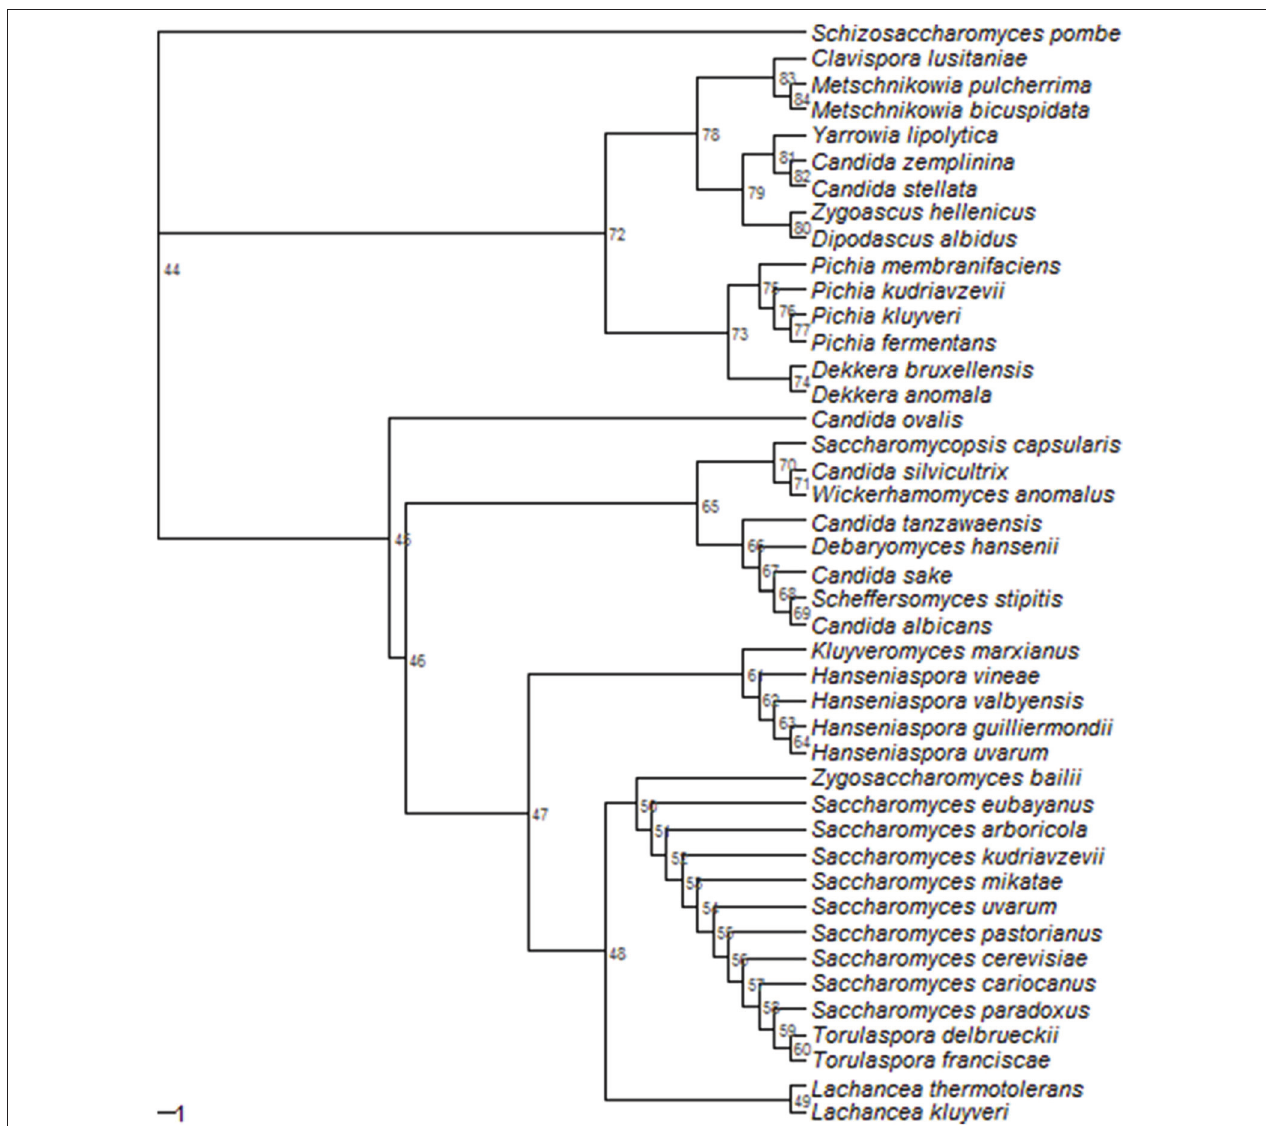
FIGURE 1 | Phylogeny of 41 species of Saccharomycetales on the basis of 18S ribosomal DNA sequence. Multiple sequence alignment (1951 bases) was performed by Clustal Omega (EMBL-EBI website). Genetic distance was computed using the K80 Kimura model (Kimura, 1980), phylogenetic tree was built using Neighbor joining clustering method and bootstrapping (1000 replicates) was used to assess the robustness of the nodes by means of R package ape (Paradis et al., 2004). Schizosaccharomyces pombe was used as outgroup species. The following sequences and strains (mostly type strains) were used: AB000642.1| Dipodascus albidus IFO 1984; AB013504.1| C. tanzawaensis JCM 1648; AB018175.1| C. stellata JCM 9476; AB023473.1| M. pulcherrima IFO 1678; AB040997.1| S. kudriavzevii IFO 1802; AB040998.1| S. mikatae IFO 1815; AB054561.1| C. silvicultrix JCM 9831; AB013529.1|C. sake JCM 2951; AF548094.1| S. cerevisiae CBS 1171; AJ271813.1| S. cariocanus UFRJ 50816; AY046254.1| H. valbyensis NRRL Y-1626; AY046256.1| H. guilliermondii NRRL Y-1625; AY046257.1| H. uvarum NRRL Y-1614; AY046258.1| H. vineae NRRL Y-17529; S. bacillaris CBS 9494; EF550365.1| P. membranifaciens NRRL Y-2026; EF550372.1| P. fermentans Y-1619; EF550389.1| P. kluyveri NRRL Y-11519; EF550396.1| D. anomala NRRL Y-17522; EF550479.1| Wickerhamomyces anomalus NRRL Y-366; EU011714.1| C. ovalis NRRL Y-17662; EU011734.1| D. bruxellensis NRRL Y-12961; EU348783.1| C. albicans NRRL Y-12983; FJ153136.1| L. thermotolerans NRRL Y-8284; FJ153143.1| T. franciscae NRRL Y-6686; GU266277.1| S. arboricola AS 2.3317; GU597328.1| Zygoascus hellenicus CBS 5839; HQ651939.1| Scheffersomyces stipitis ATCC 58376; JQ698884.1| Saccharomycopsis capsularis NRRL Y-17639; JQ698900.1| Clavispora lusitaniae NRRL Y-11827; JQ698910.1| Debaryomyces hansenii NRRL Y-7426; JQ698926.1| Yarrowia lipolytica NRRL YB-423; JQ698936.1| Schizosaccharomyces pombe NRRL Y-12796; M55528.1| P. kudriavzevii MUCL 29849; S. eubayanus FM1318; S. uvarum CBS7001; X69846.1| M. bicuspidata MUCL 31145; X89523.1| L. marxianus CBS 712; X91083.1| Zygosaccharomyces bailii NCYC 1416; X97805.1| S. pastorianus NCYC 392; X97806.1| S. paradoxus CBS 432; X98120.1| T. delbrueckii CBS 1146; Z75580.1| L. kluyveri NCYC 543.